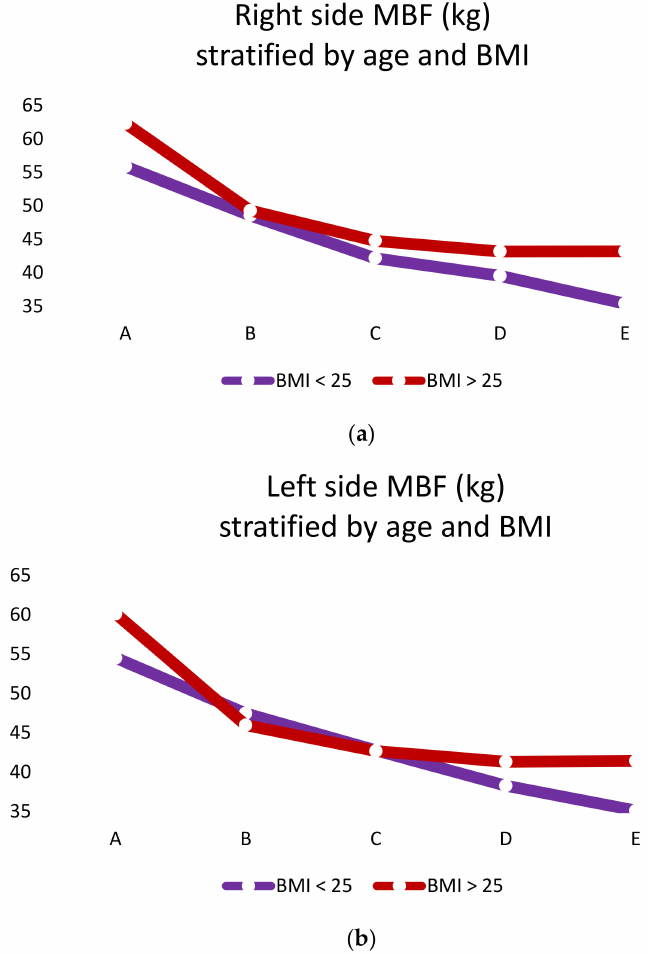
Figure 2. ( a ) Right side MBF (kg) stratified by age and BMI; ( b ) left side MBF(KG) stratified by age and